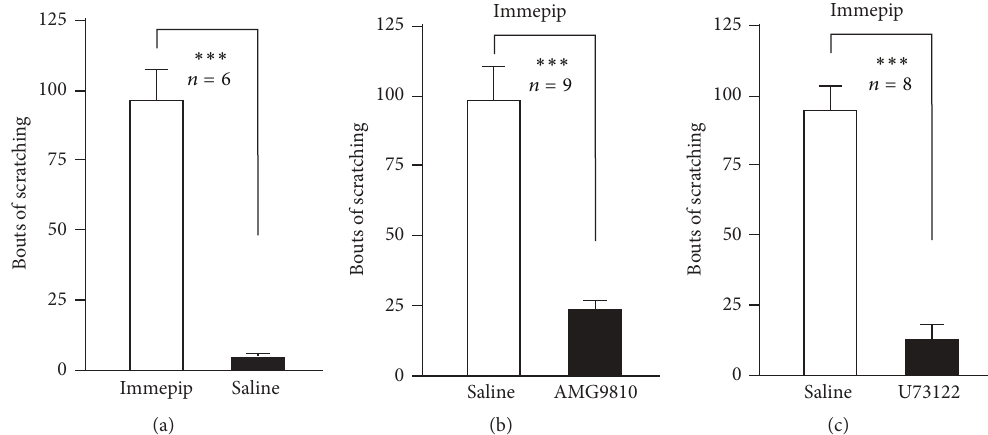
Figure 6: AMG9810 and U73122 inhibited immepip-induced scratching in mice. The histogram shows bouts of scratching by injection of immepip 100 𝜇 mol and saline 100 𝜇 L/site ( 𝑛 = 6 ) (a). (b) Saline (PBS) 100 𝜇 L/site or AMG9810 5 𝜇 M 100 𝜇 L/site 30 minutes pretreated before immepip subcutaneous injection. Saline (PBS) 100 𝜇 L/site or U73122 1 𝜇 M 100 𝜇 L/site 30 minutes pretreated before immepip subcutaneous injection in (c). The data are presented as mean ± SEM ( ∗∗∗ 𝑃 < 0.001